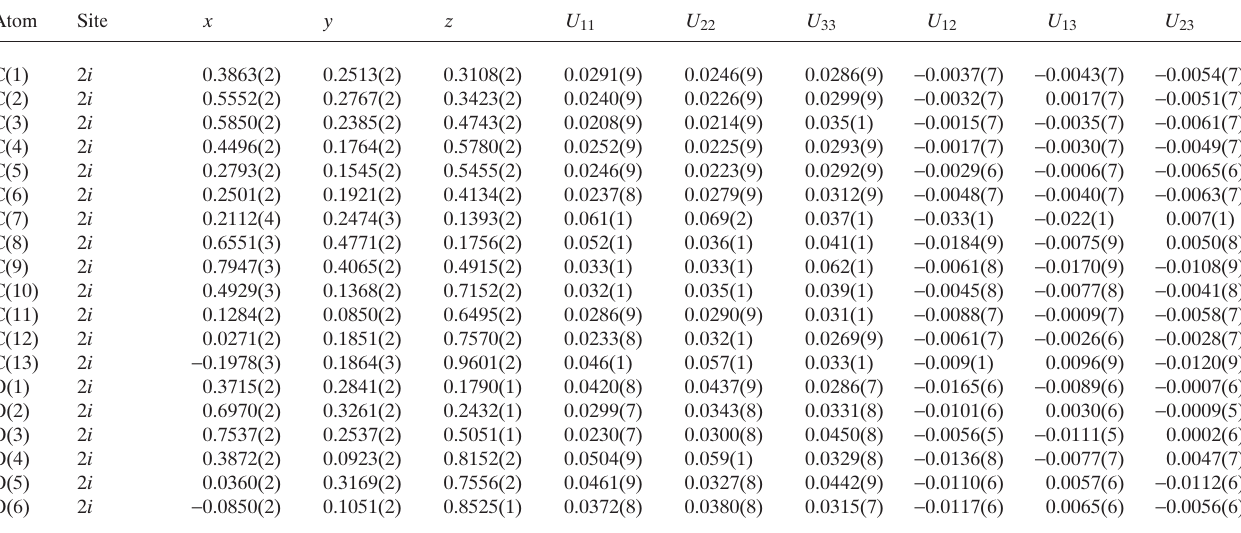
Table 3. Atomic coordinates and displacement parameters (in Å 2 )